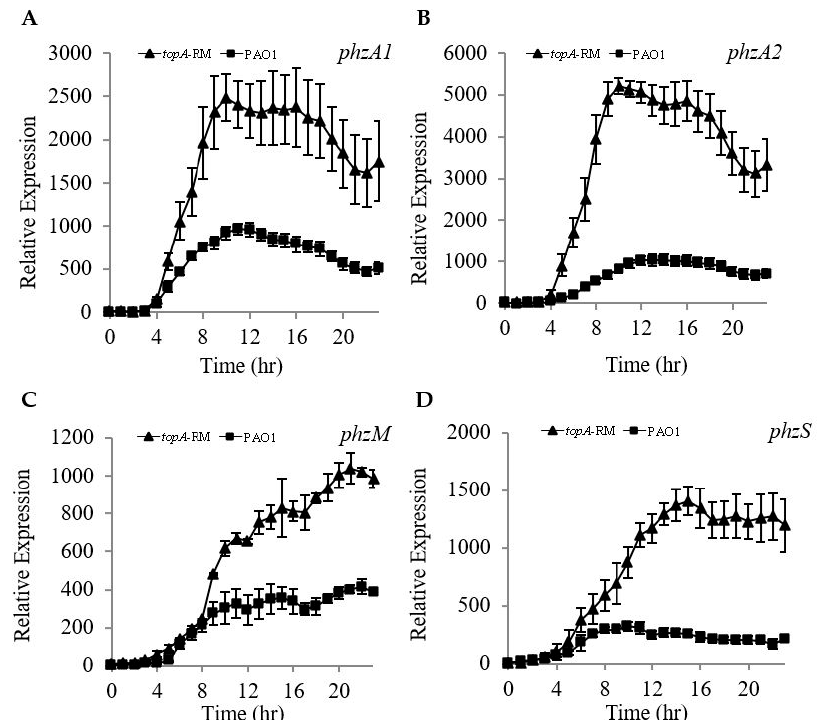
Figure 3. Activated promoter activity of the genes involved in PYO synthesis. The promoter activity of phzA1 operon ( A ), phzA2 operon ( B ), phzM ( C ), and phzS ( D ) in topA -RM was measured using the p- lux reporter system. The expression levels are presented as cps normalized to OD 595 . The values in topA -RM are shown as triangles and those in PAO1 as squares (data shown as averages from triplicate experiments ± standard errors of the means).